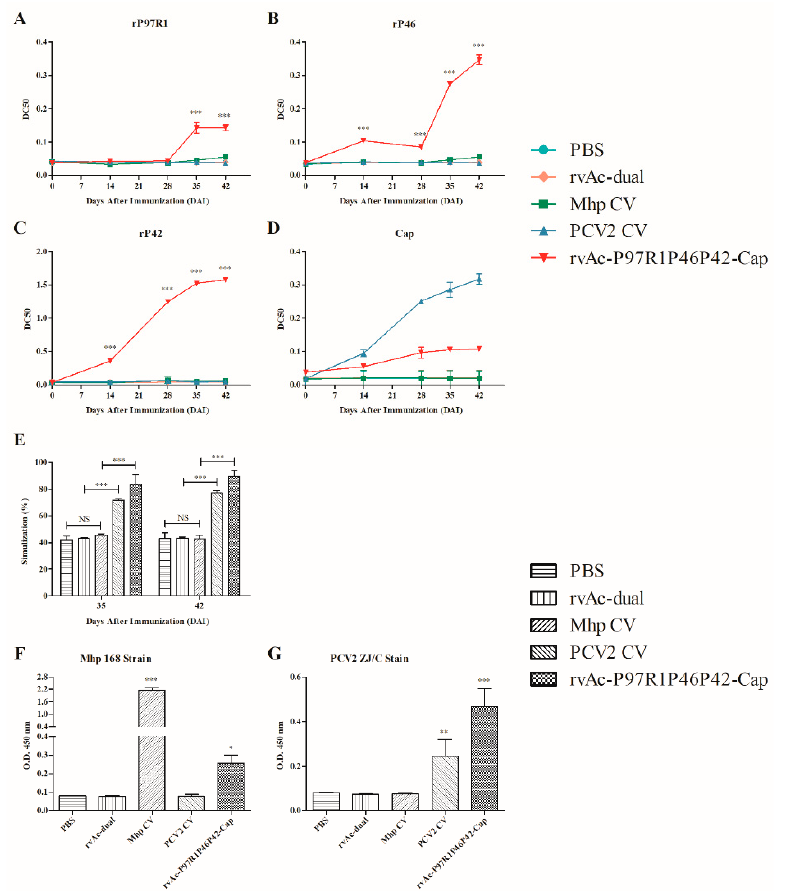
Figure 6. Analysis of mouse immunization by indirect ELISA and lymphocyte proliferative experiments. Analysis of the immunoglobulin G (IgG) response induced by mouse immunization determined by indirect ELISA with four recombinant proteins ( A – D ). ( A ) Total IgG level against rP97R1; ( B ) Total IgG level against rP46; ( C ) Total IgG level against rP42; ( D ) Total IgG level against Cap. The Y axis represents the mean EC50 (concentration for 50% of maximal effect) of serum samples collected at 0, 14, 28, 35, and 42 days after immunization (DAI) in each group. *** p < 0.001, significantly different from the PBS, rvAc-dual, Mhp CV, and PCV2 CV groups (Bonferroni test). Lymphocyte proliferative experiment results ( E ). The Y axis represents the stimulation of splenic lymphocyte samples collected at 35 and 42 DAI. NS: not significantly different; *** p < 0.001, significantly different (Bonferroni test). Analysis of the IgG response induced by mouse immunization determined by indirect ELISA against Mhp 168 and PCV2 ZJ/C strains ( F , G ). ( F ) Total IgG level against Mhp 168 strain; ( G ) Total IgG level against PCV2 ZJ/C strain. The Y axis represents the mean OD 450 of serum samples collected at 42 DAI in each group. * p < 0.05, ** p < 0.01, and *** p < 0.001, significantly different from the PBS and rvAc-dual groups (Bonferroni test). All analyses were performed in triplicate, and the error bars demonstrate standard deviations (SD).